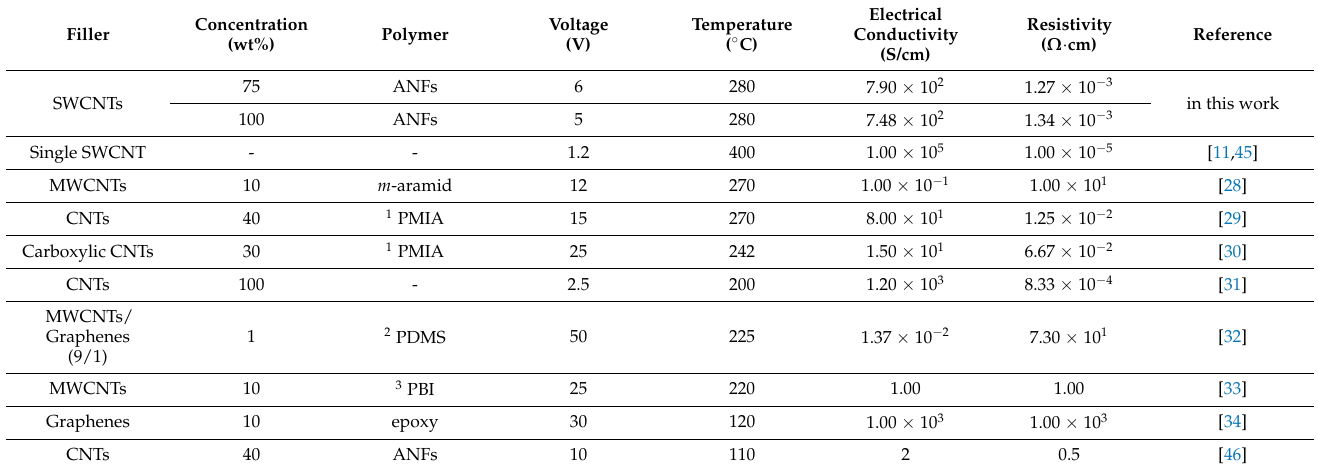
Table 1. Heating temperature and input voltage of our nano-filler-based composite sheet compared with those previously